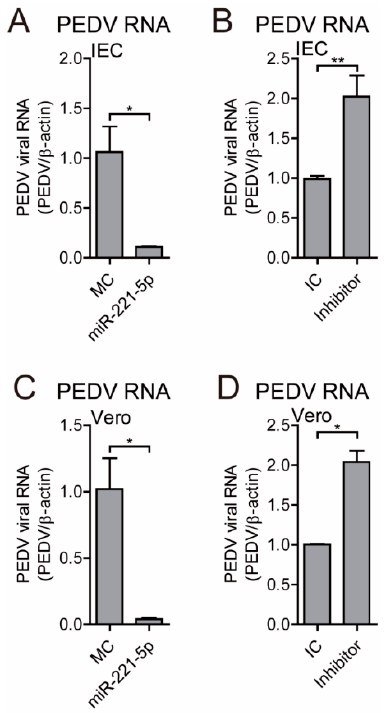
Figure 3. miR-221-5p inhibits PEDV replication in IECs and Vero cells. Real-time qRT-PCR analysis of intracellular viral genomic RNA (normalized to β -actin expression). IECs were transfected with miR-221-5p mimics ( A ) or inhibitor ( B ) at 50 nM for 12 h, followed by infection with PEDV CV777 for an additional 36 h. Vero cells were transfected with miR-221-5p mimics ( C ) or inhibitor ( D ) at 50 nM for 12 h, followed by infection with PEDV CH/HBTS/2017 for an additional 36 h. Data represent the mean ± SD of three independent experiments and measured in technical duplicate. Comparisons between groups were determined by Student’s t test. * p < 0.05; ** p <